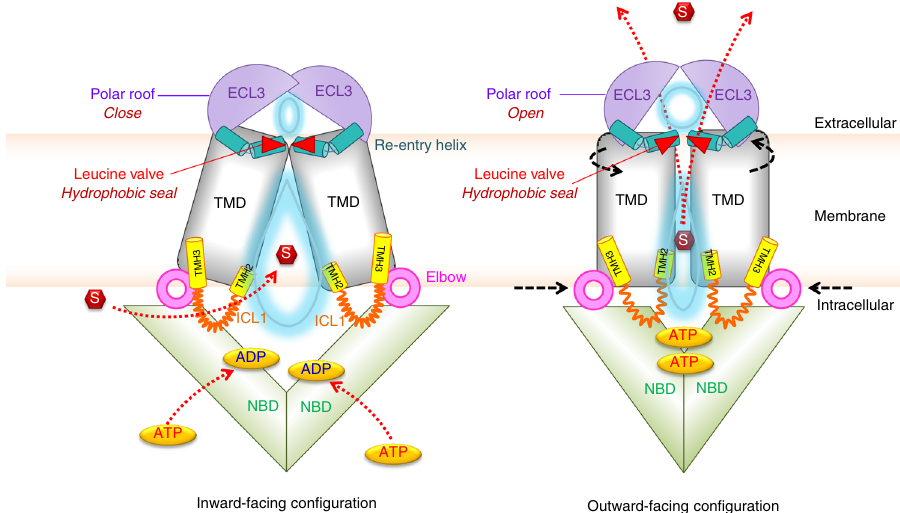
Fig. 7 Model of ABCG2 transport cycle and drug movement through the di-leucine valve. The extracellular region, including the re-entry helix (cyan), di- leucine valve (red triangle), and ECL3 (violet), plays a vital role in translocation of substrate (red) from the central cavity (light blue water drop-shape) to the upper cavity (light blue oval) for drug release. Transmission interface, NBD (green), elbow helix (pink), distal parts of TMH2 and TMH3 (yellow), and ICL1 (orange) are essential for NBD-TMD interaction, which transmit the conformational switching, represented by black arrows. Red arrows indicate the directions of substrate or ATP translocations. See main text for further